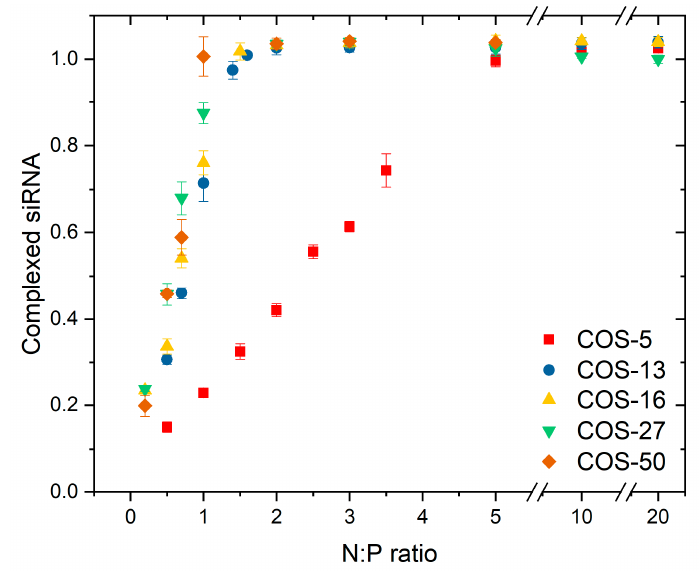
Figure 6. The fraction of complexed siRNA (ratio of the concentration of complexed siRNA to the total siRNA concentration) as function of the N:P ratio, determined by titration of free siRNA with toluidine blue in 0.1 M acetate buffer pH 4.0.